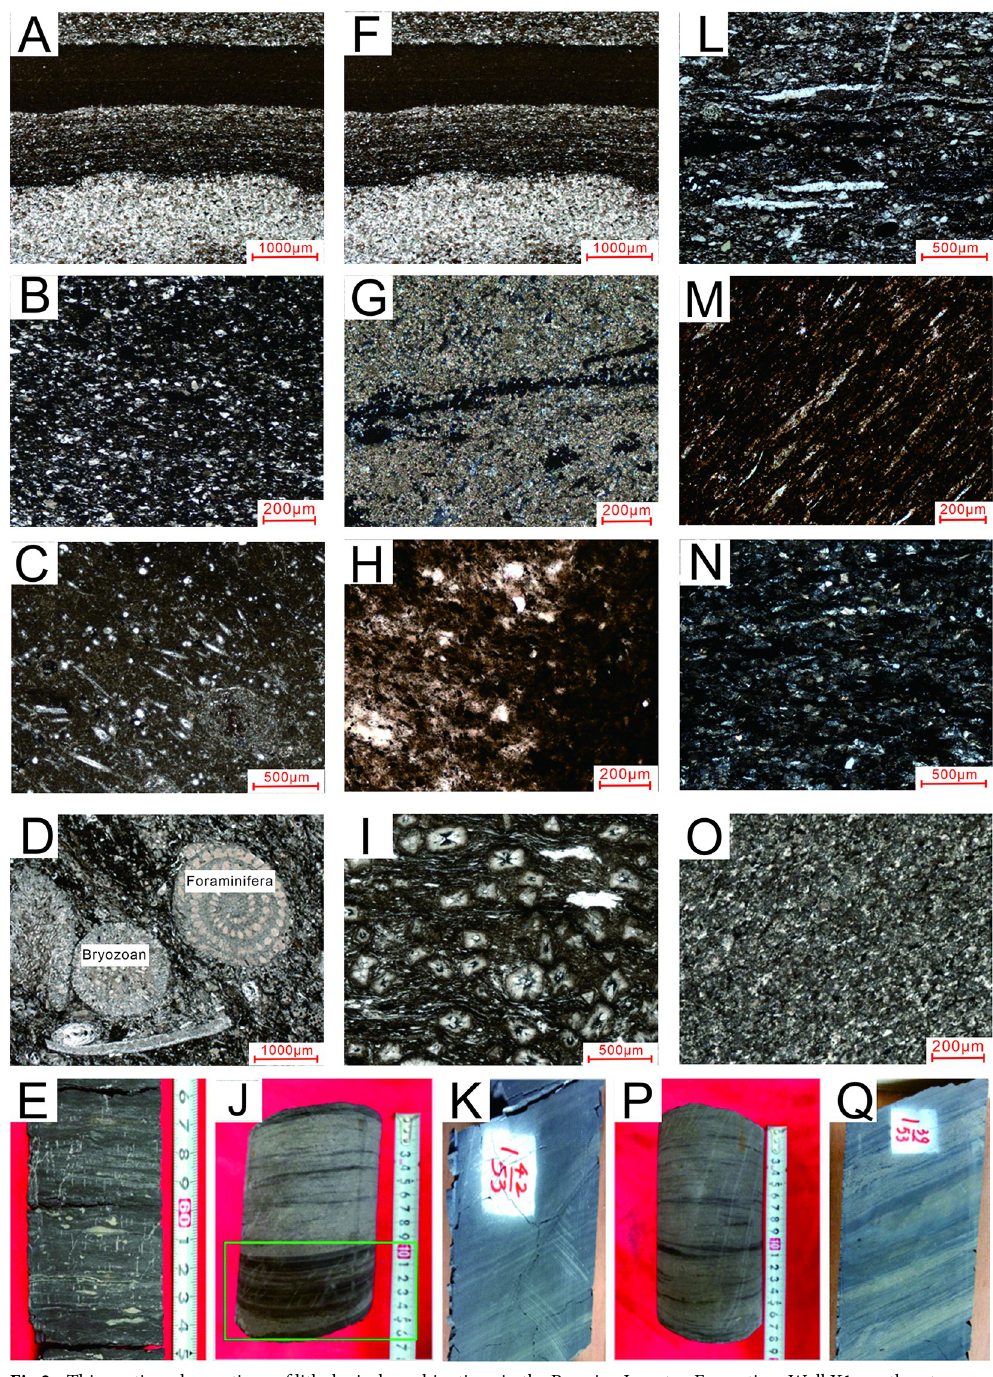
Fig 2. Thin section observations of lithological combinations in the Permian Longtan Formation, Well X1, southeastern Sichuan Basin: (A) Sample 3#: Argillaceous siltstone. The aggregation of clay minerals is mainly banded, and organic matter is clumpy and fine-banded, 5 × 10 (-); (B) Sample 7#: Shale. Organic matter is distributed along the bedding, 5 × 10 (-); (C) Sample 9#: Silty shale. Silty lamination develops, and organic matter is black-speckled, clumpy, and banded, 5 × 10 (-); (D) Sample 3#: Siltstone with mud. Organic matter is black, clumpy, and banded, 5 × 10 (-); (E) Bivalves and bryophytes. Bioturbation, horizontal bedding, nodular siderite; (F) Sample 4#: Shale with dolomite. Organic matter develops bedding, 10 × 10 (+); (G) Sample 6: Shale with siltstone. Bedding development, and organic matter develops bedding, 10 × 10 (-); (H) Sample 3#: Shale with bioclasts. Bioclasts are mainly spongy spicules scattered in rocks in needle-like and elliptical shapes, 5 × 10 (+); (I) Sample 8#: Carbonaceous mudstone. The mudstone is yellow-brown and is mainly an aggregation